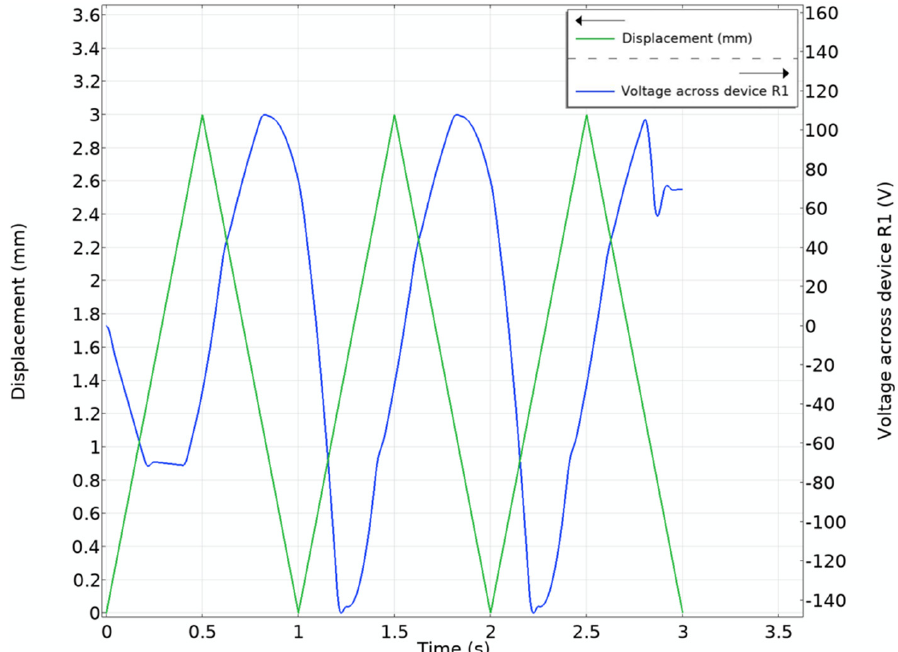
Figure 11. Time-dependent displacement (mm) and voltage (V) simulation on COMSOL ® . To assess the feasibility of this PEH, however, the power that can be generated must be determined by terminating the circuit with a matched resistor. Figure 12 plots the voltage (V) and power (mW) readings across the time-dependent study, spanning three seconds.